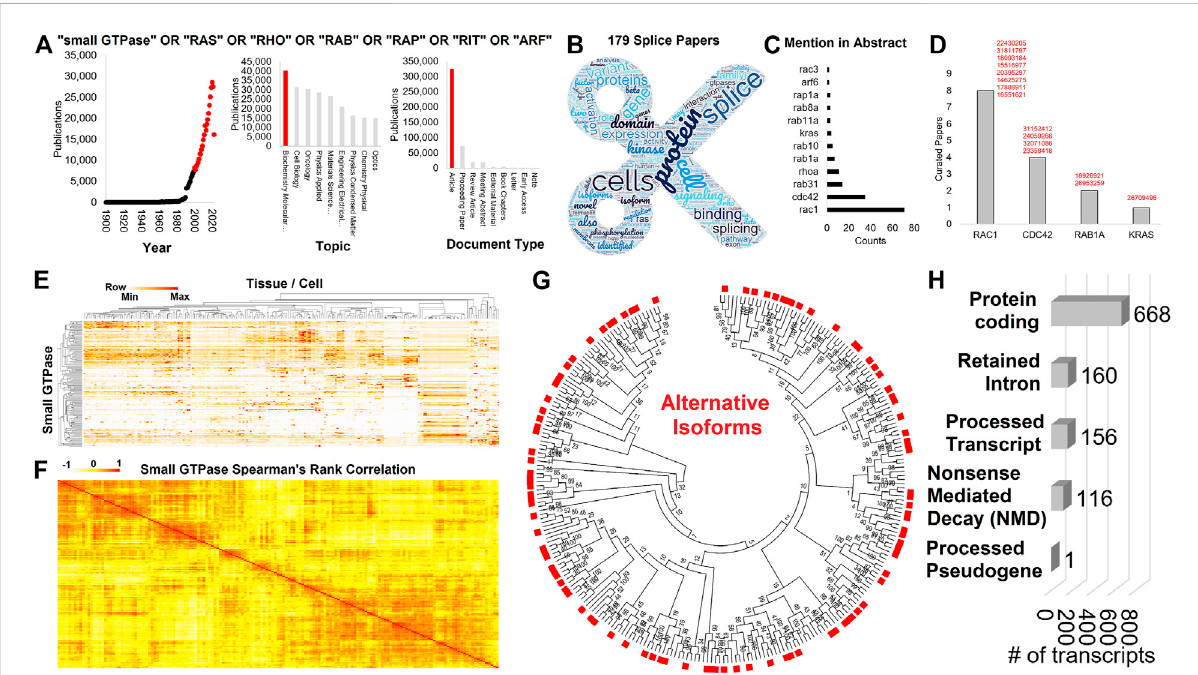
FIGURE 1 ExpressionandisoformsofsmallGTPasefamilygenes. (A) WebofScienceextractionforsmallGTPaseORRASORRHOORRABORRAPORRIT OR ARF followed by analysis of papers for year, topic, and document type. Those categories in red were selected for further analysis. (B) Word cloud of top terms extracted from the abstract of the 179 papers using panel A inclusion and the word splice. (C) The number of times any small GTPase gene is included in the abstracts of (B) . (D) The number of curated manuscripts for small GTPase genes that include isoform information. The PMID codes are listed next to each gene in red. (E) Heat map of the Human Protein Atlas expression for each small GTPase family member ( y -axis) across multiple human tissue and cell ( x -axis). Clustering is based on one minus Spearman ’ s rank correlation. Coloring is based on the z-score for each gene, with the middle level in yellow and the highest in red. (F) Spearman ’ s rank correlation for each of the small GTPase family members to each other based on (A) expression. (G) A maximum likelihood tree for all UniProt annotated isoforms of small GTPase members. Red boxes are alternative protein isoforms from the primary annotated form (no red box). (H) Annotated Biotypes for small GTPase isoforms from Gencode